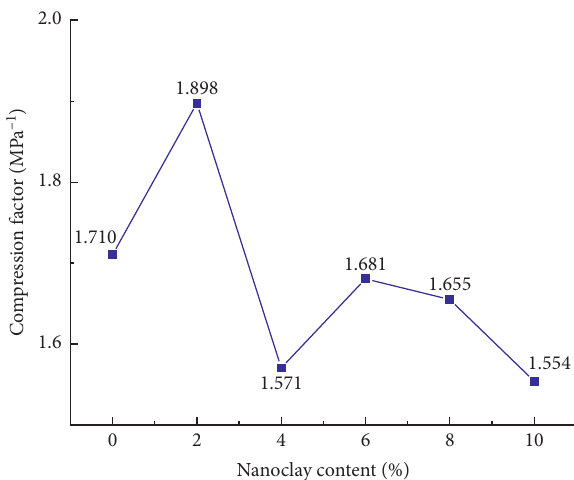
Figure 13: a 1-2 of NCS-7 of different nanoclay content.